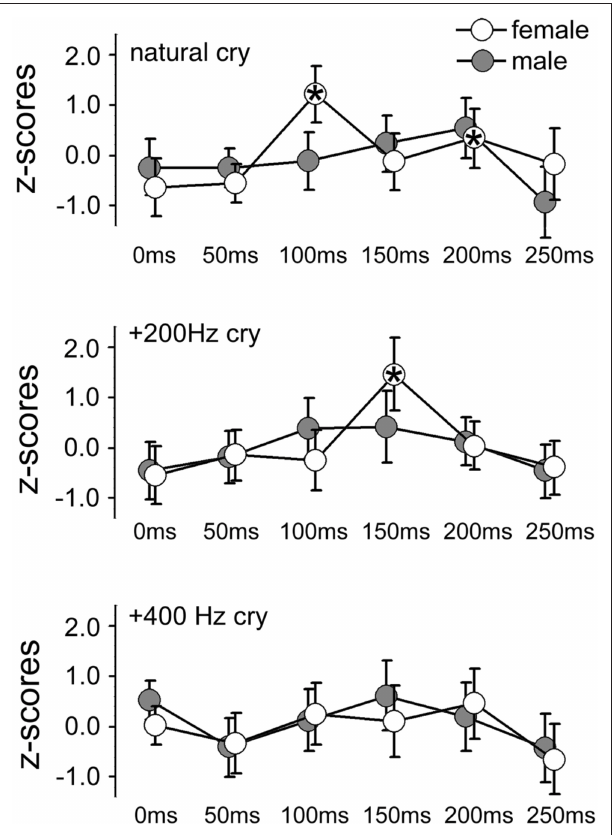
FIGURE 1 | Mean z -scores pooled from all participants and across all cry types. (A) shows data from the ID1 muscle and (B) data from the BB muscle. Bars indicate 95% CIs. The dashed line represents the mean value obtained at 0ms (baseline). P -values indicate significant differences between the data obtained at 0ms and the data obtained at the other 5 ISIs. Significant time-points are indicated with asterisks.